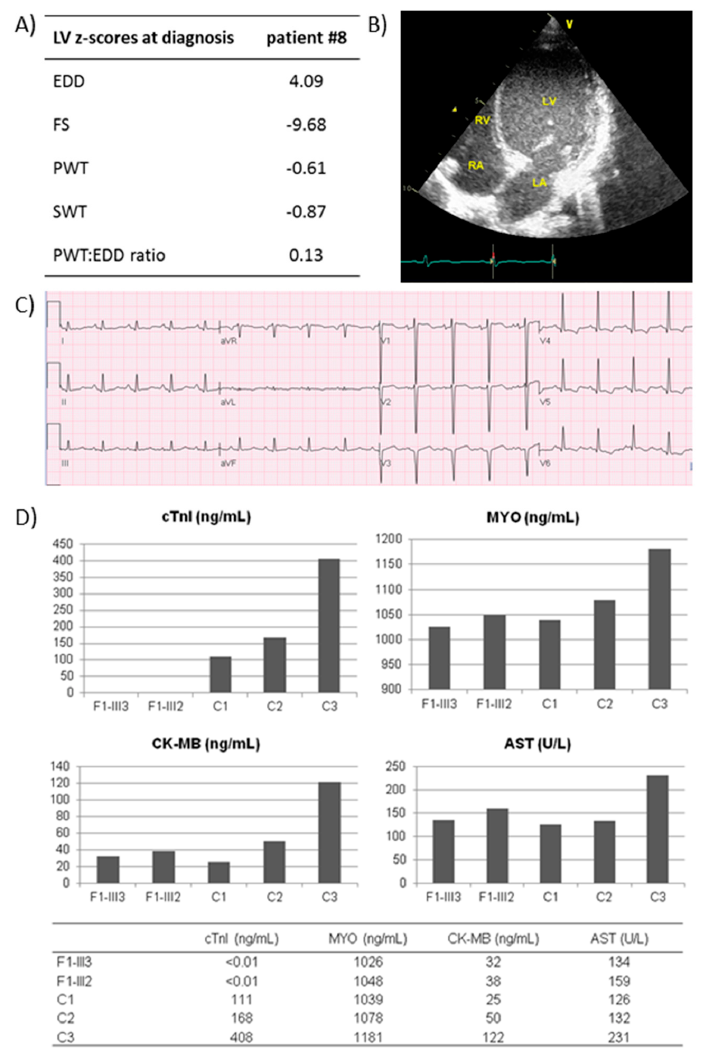
Figure 3. Clinical presentation and cTnI tissue levels of patients with homozygous TNNI3 (OMIM *191044) variants. ( A ) Clinical data at admission of patient #8. ( B ) Two-dimensional echocardiogram of patient #8, showing a dilated left ventricle and left atrium, with rightward shift of the interatrial and interventricular septum and thin left free-walls. ( C ) Electrocardiogram of patient #8, showing low-voltage QRS complexes in inferior and lateral leads, no R wave progression in leads V1–V3 and T-wave inversion in leads V4–V6. ( D ) Histograms showing the tissue level of cTnI, myoglobin (MYO), muscular isoforms of creatine kinase (CK-MB) and aspartate aminotransferase (AST) in myocardial specimens from explanted frozen left ventricle of patient #41, her affected sister and three negative controls. F1-III3, patient #41; F1-III2, affected sister of patient #41; C1, age-matched hypertrophic cardiomyopathy patient; C2, age-matched idiopathic dilated cardiomyopathy patient; C3, adult ischemic cardiomyopathy patient. Abbreviations: LV, left ventricle; LA, left atrium; RV, right ventricle; RA, right atrium; EDD, end-diastolic dimension; FS, fractional shortening; PWT, posterior wall thickness; SWT, septal wall